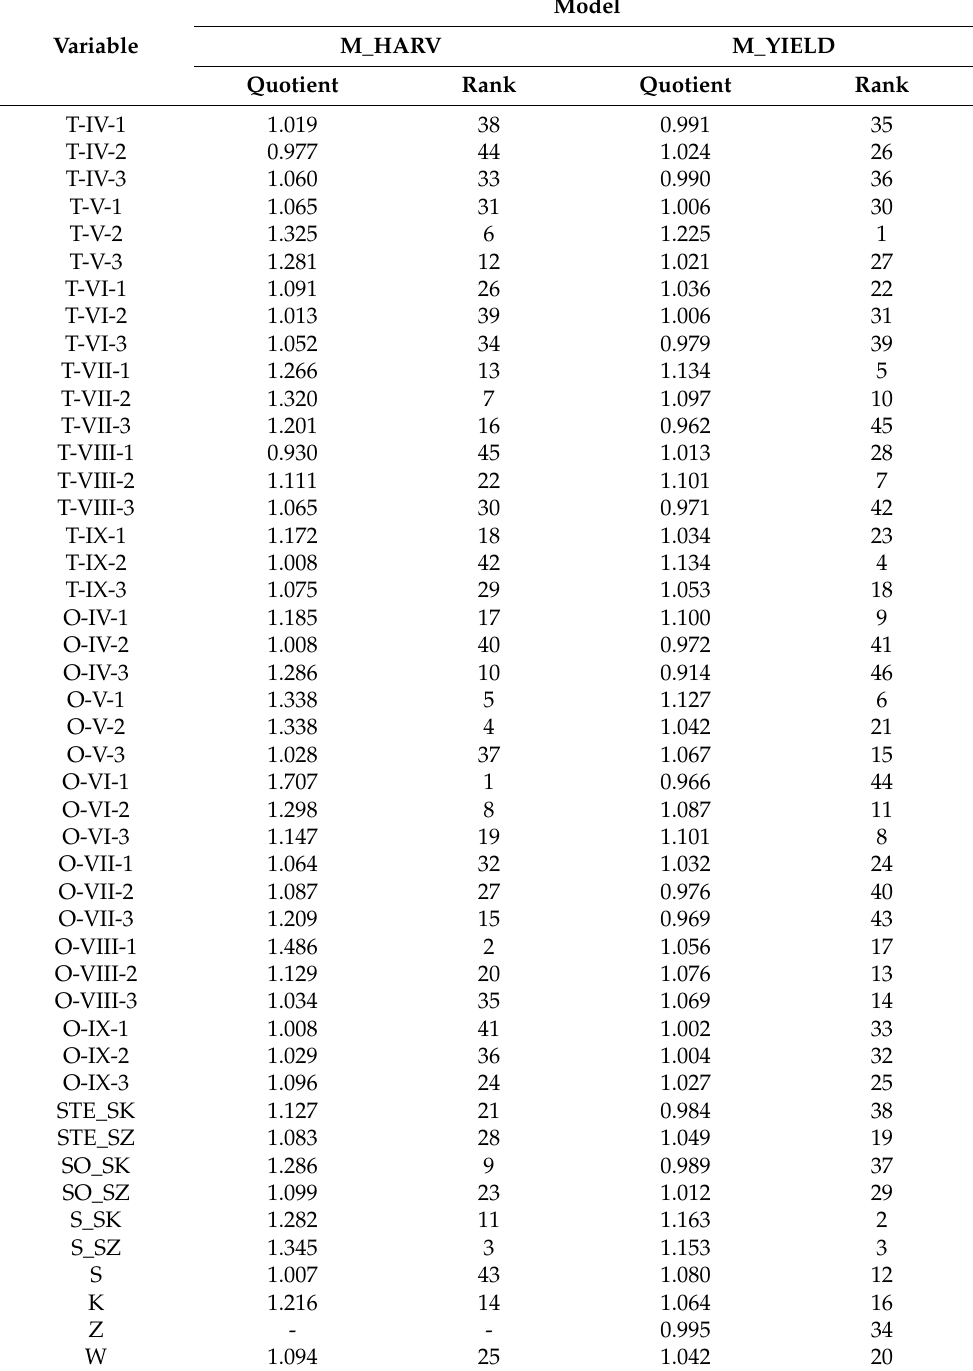
Table 3. A sensitivity analysis of the neural